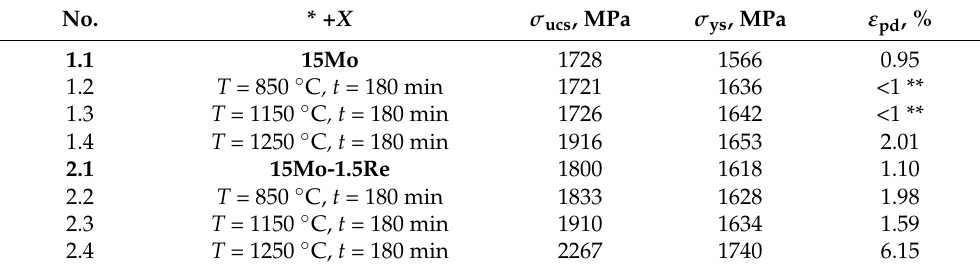
Table 10. Mechanical properties during the compression tests at T = 20 ◦